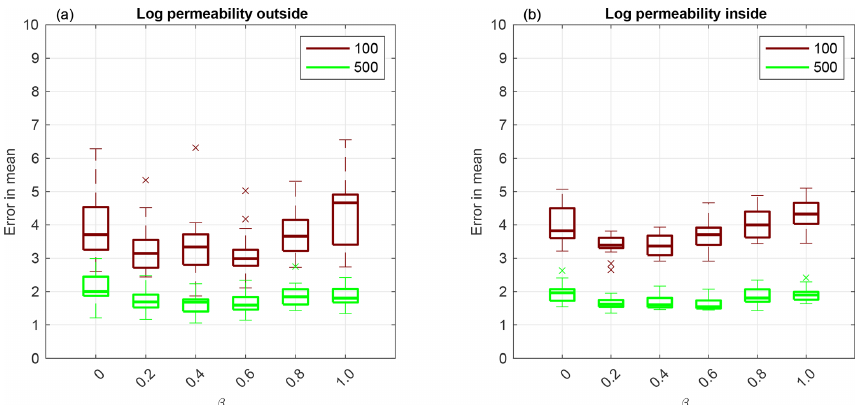
Figure 7. Application to F2 parameterisation using Sinkhorn approximation. Box plot over 20 independent simulations of RMSE of mean log permeability outside the channel (a) and inside the channel (b) . The horizontal axis is for the hybrid parameter, where β = 0 corresponds to the EKI and β = 1 to TET(S)PF. The ensemble size M = 100 is shown in red and M = 500 in green. The central mark is the median, the edges of the box are the 25th and 75th percentiles, whiskers extend to the most extreme data points and crosses are outliers.